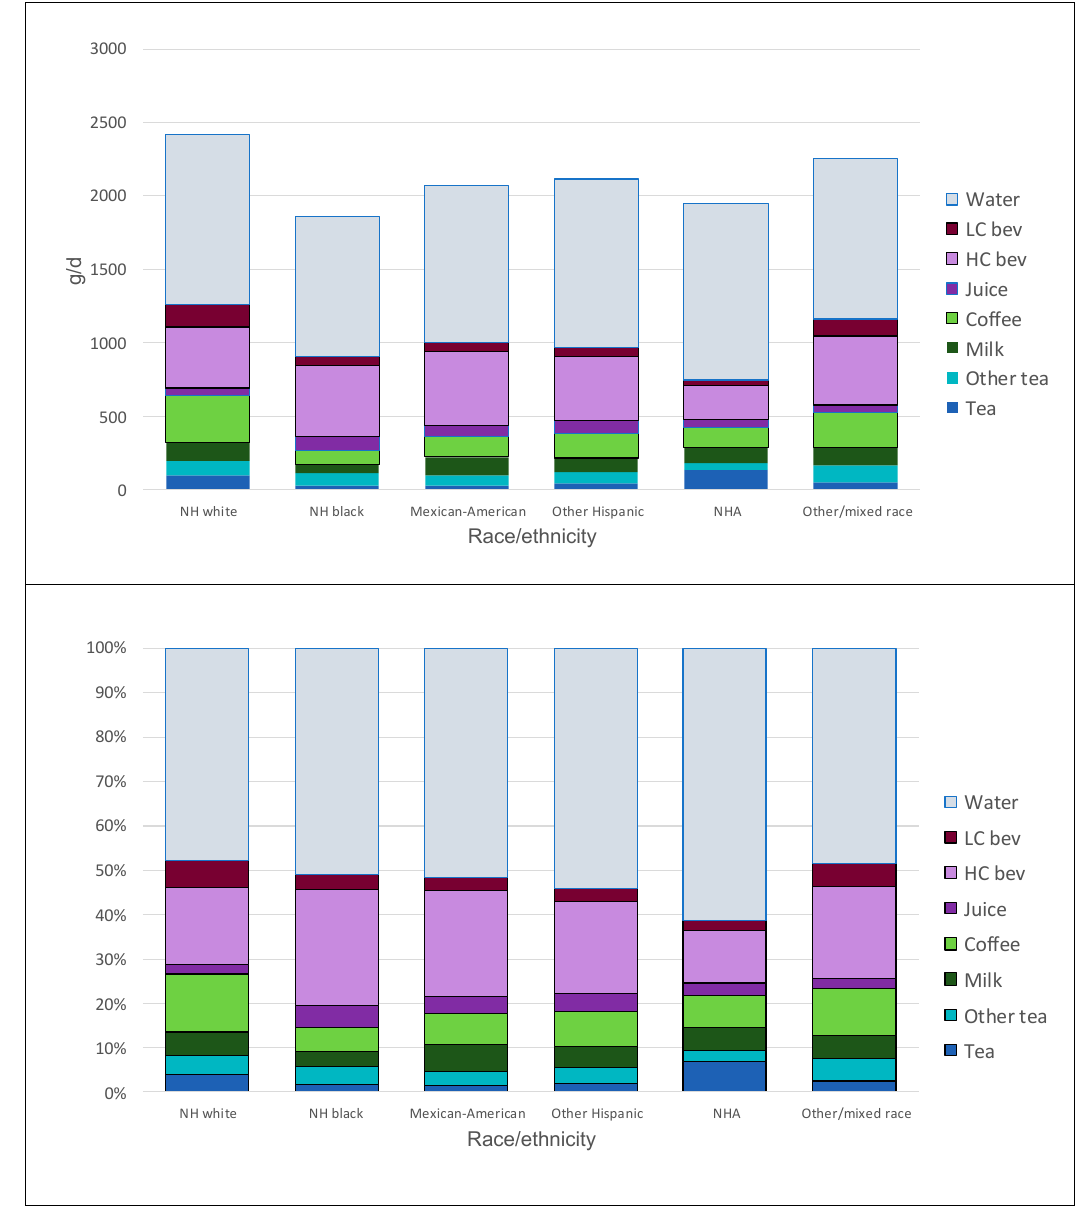
Figure 2. Tea and beverage consumption patterns by race/ethnicity. Top panel shows amounts in g/day, while bottom panel shows percentages of total beverage consumption by beverage category.